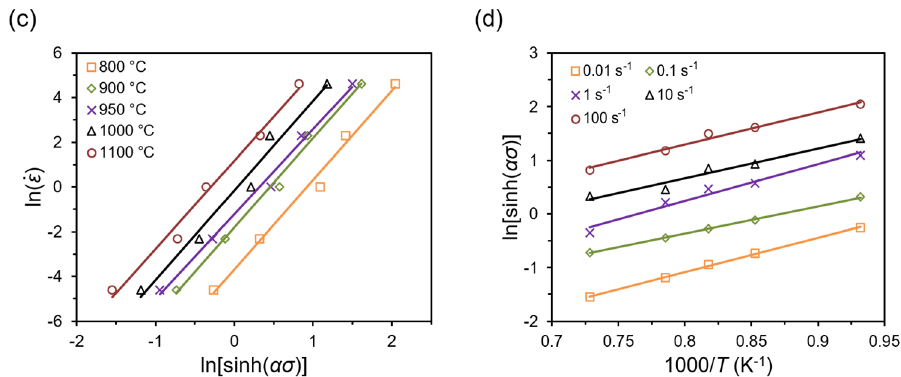
. . . ε and ln σ , ( b ) ln ε and σ , ( c ) ln ε and ln[sinh( ασ )], ( d ) ln[sinh( ασ )]